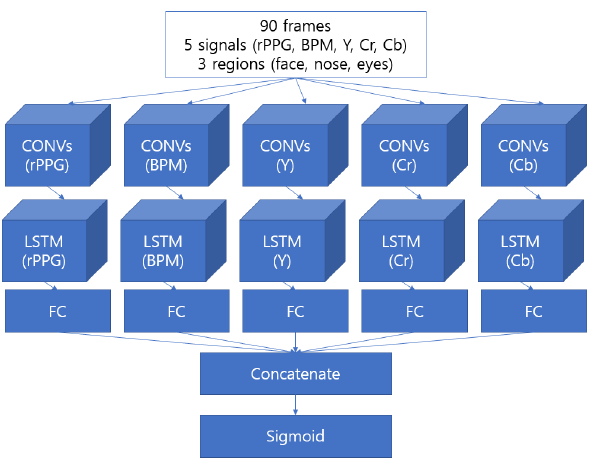
Figure 10. Structure of our CRNN-based model with every method implemented.